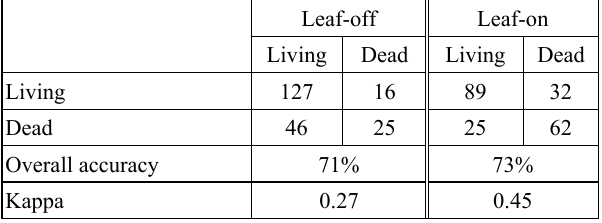
Table 7 Confusion matrix of the best classification result for